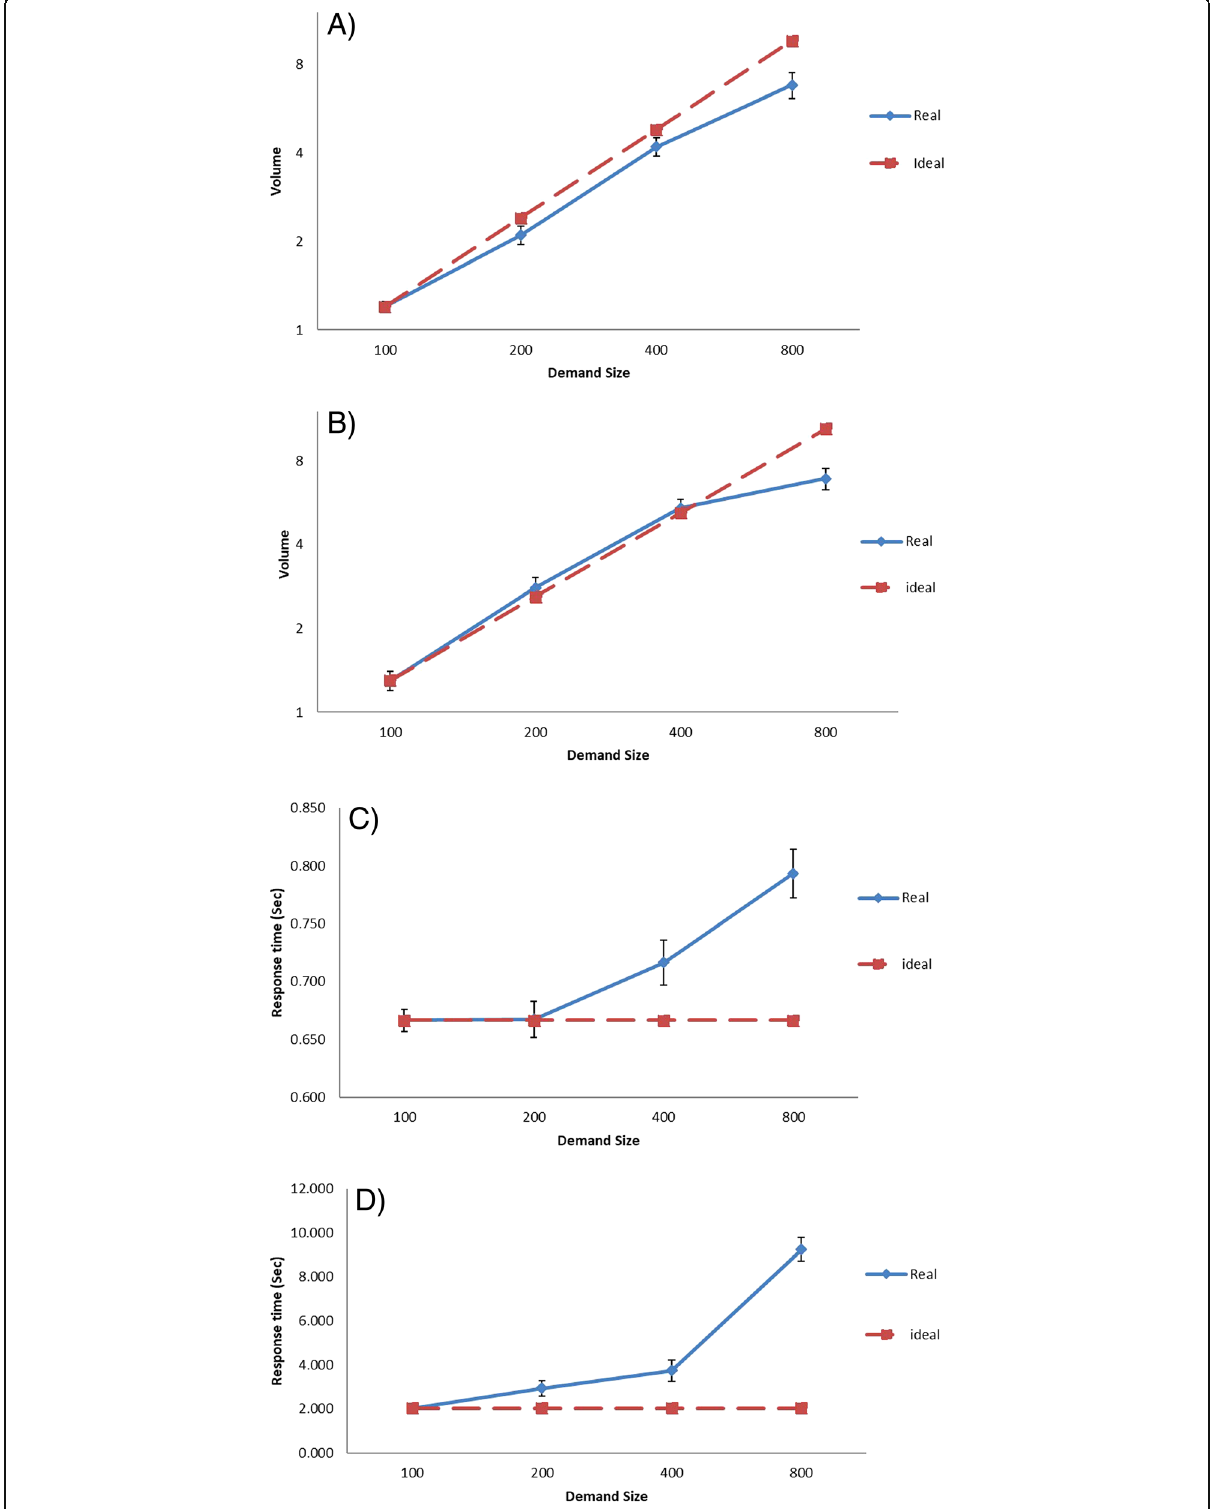
Fig. 9 The average response times and number of software instances for MediaWiki in EC2 (Option 2). a , b Average number of software instances- Steady rise and fall of demand scenario, Series of step-wise increases and decreases of demand scenario respectively. c , d ) Average response times – Steady rise and fall of demand scenario, Series of step-wise increases and decreases of demand scenario